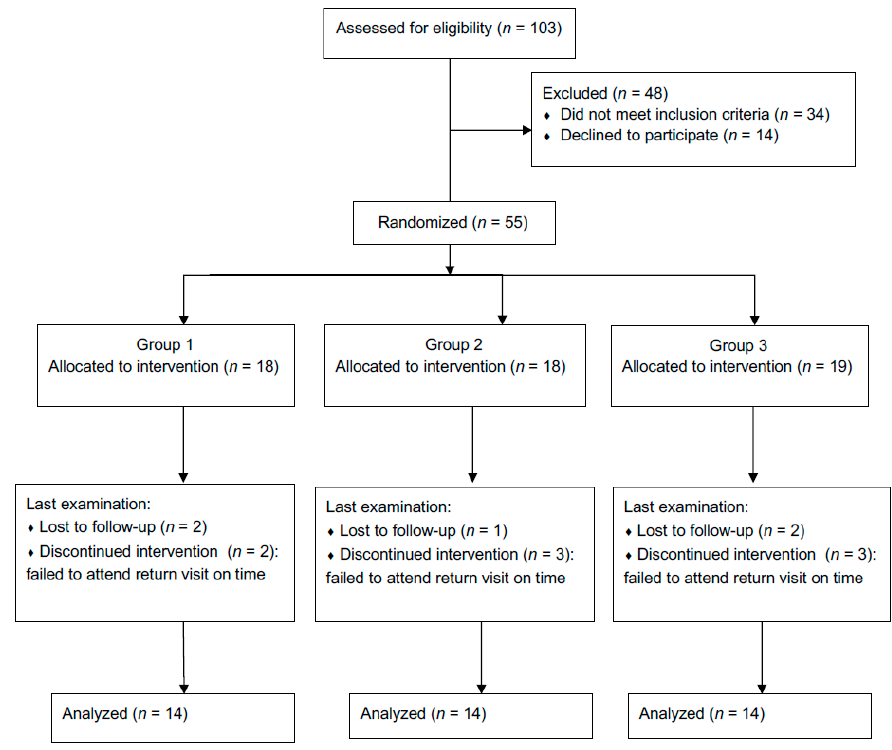
Figure 1. Flow of study phases.